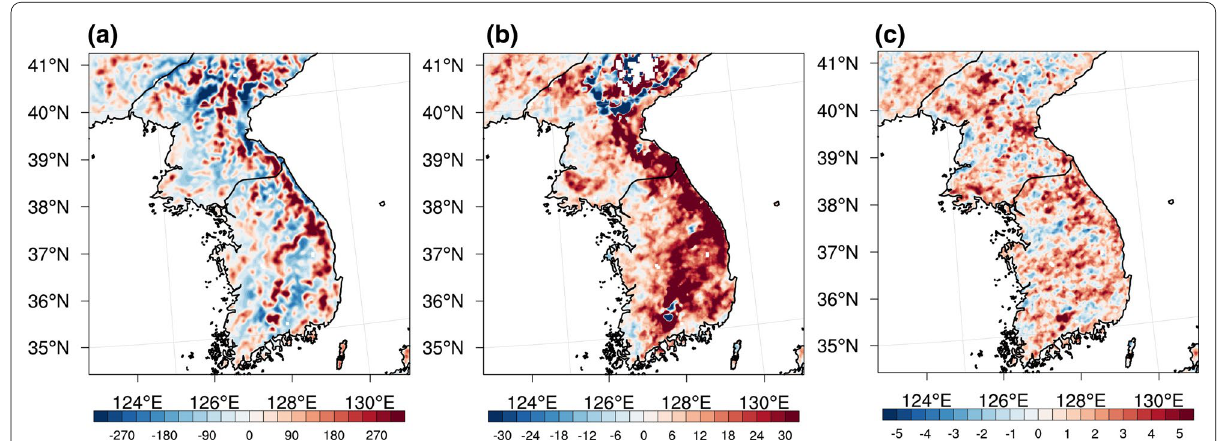
Fig. 8 Different precipitation intensities depending on the topography: the difference in temporal mean a topography (m), b share of WMB in TOTAL (%), and c precipitation intensity (mm day − 1 ) between CTRL04 and ·